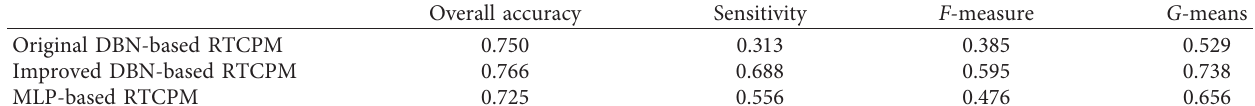
Table 3: Performance comparison of two types of DBNs and MLP.